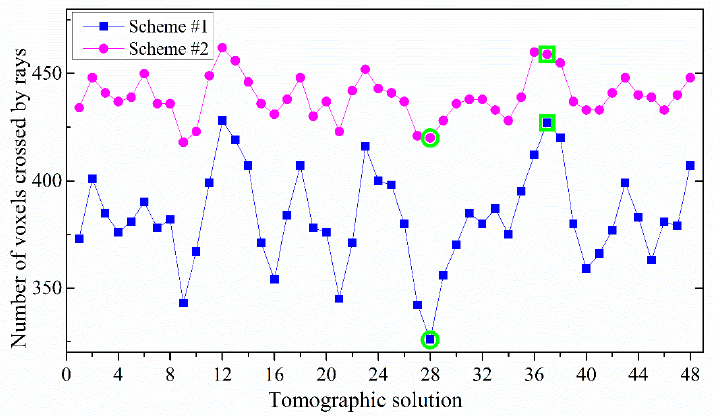
Figure 4. Number of voxels crossed by signal rays in two schemes for each tomographic solution at DOY 182, 2017.